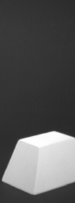
Figure 4. Grayscale secret image with a size of 512 × 512.